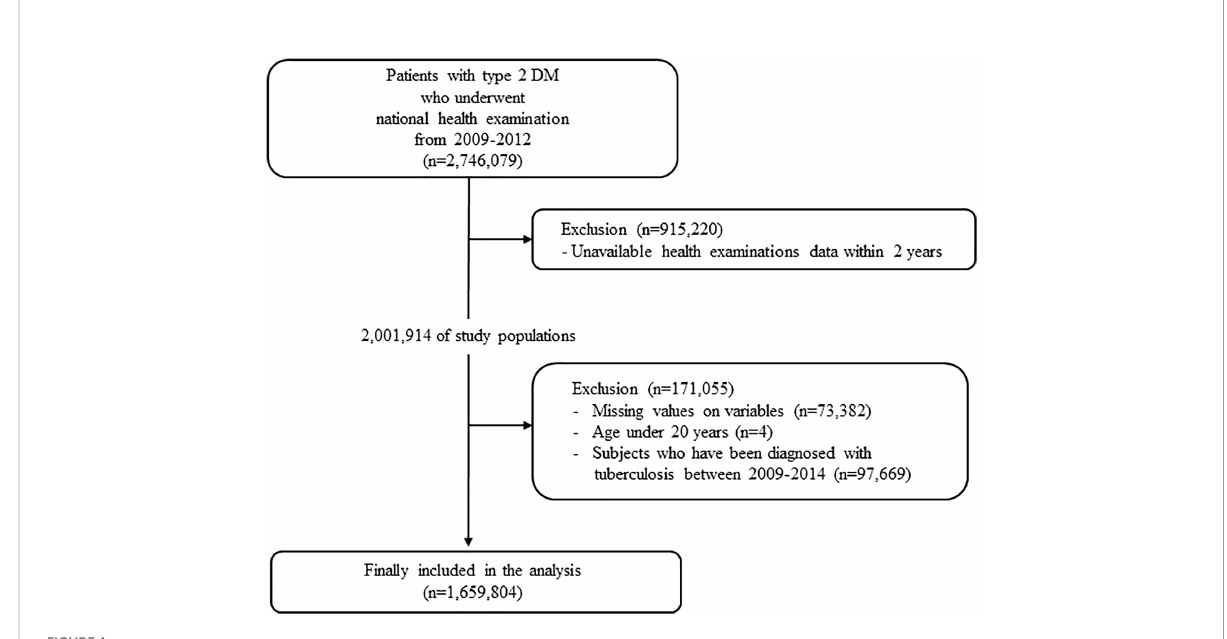
FIGURE 1 Selection of study